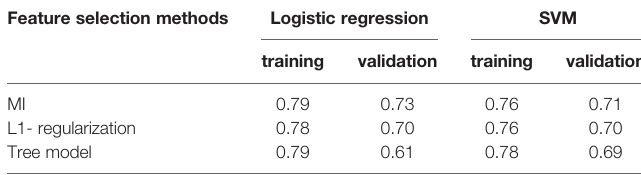
TABLE 2 | AUC value for different combination models. Feature selection methods